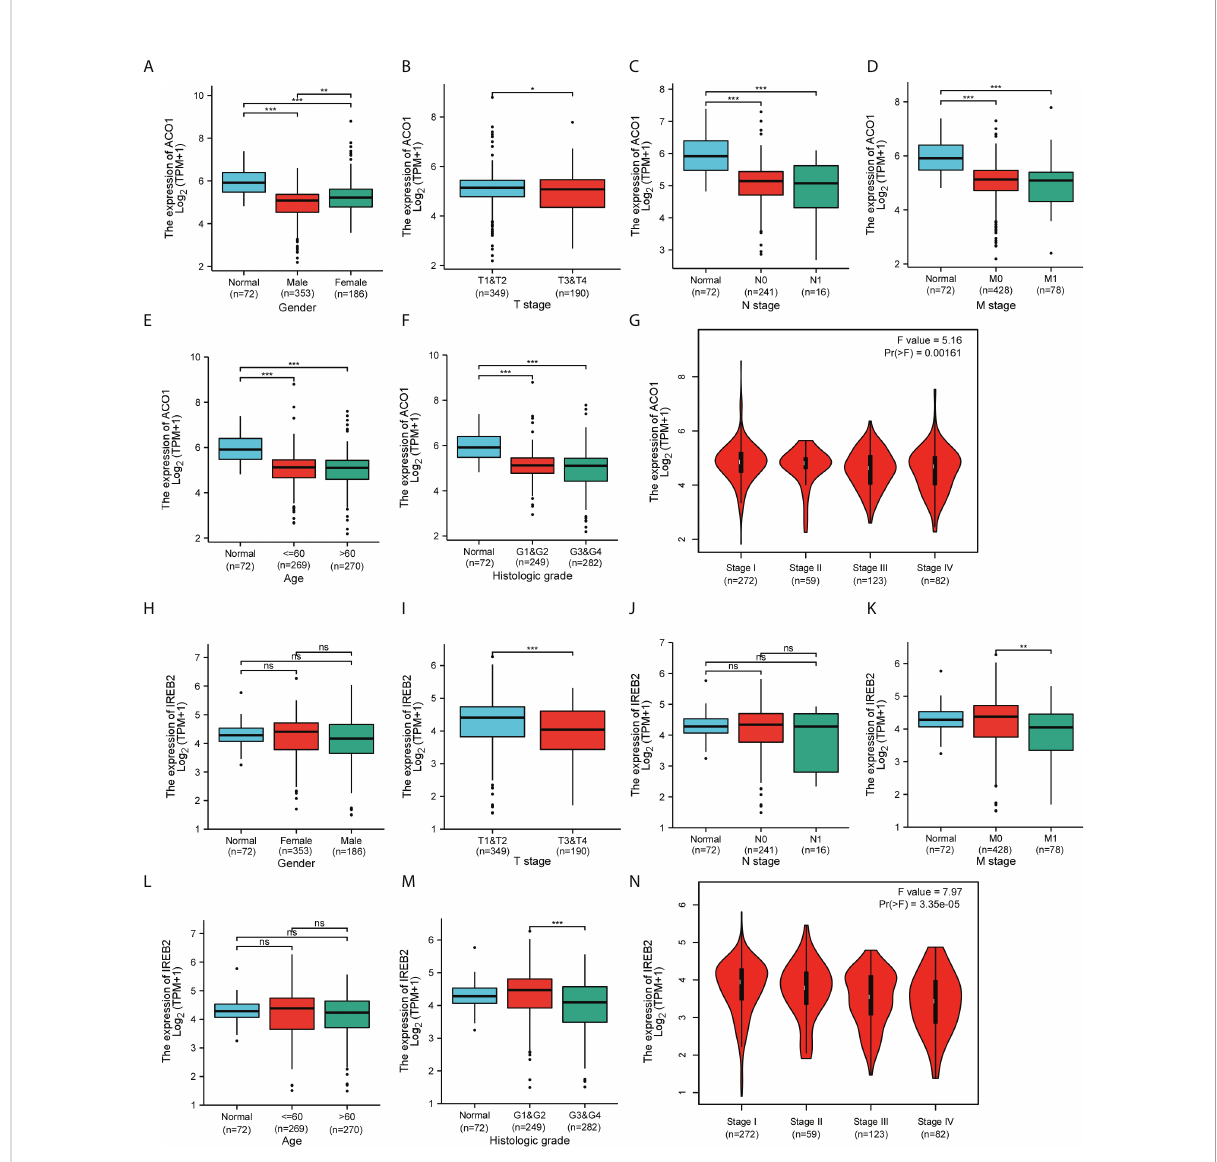
FIGURE 3 Box plots and violin plots valuating ACO1 and IREB2 expression among different groups of patients based on clinical parameters using the TCGA database. Analyses of ACO1 and IREB2 in KIRC were shown for sex (A, H) , TNM stage (B – D, I – K) , age (E, L) , histologic grade (F, M) , and cancer stage (G, N) . TNM: T: tumor, N: node, M: metastasis. Kruskal – Wallis Test and Dunn ’ s Test (A, C – F, H, J – M) ; Wilcoxon rank sum test (B, I) ; one- way ANOVA (G, N) . ns (not signi fi cant); *P < 0.05; **P < 0.01; ***P <